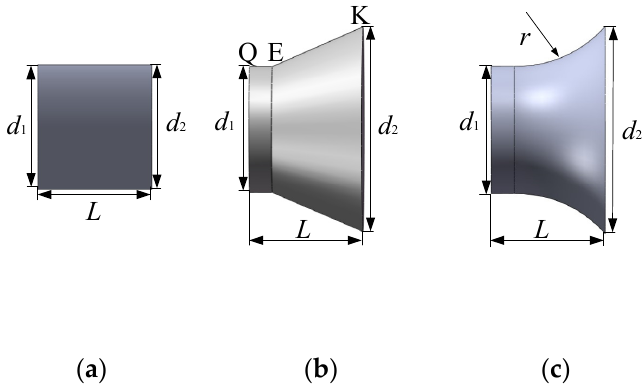
Figure 5. Structure of the seed disk hole: ( a ) cylindrical, ( b ) conical, ( c ) arc. Because of the different shapes of maize seeds can be divided into horse-tooth shapes, ellipsoid cone shapes and spheroid [34,35]. According to [36], it is known that the air- suction type seed metering device is the most difficult to suck horse-tooth shape maize seeds. From the formula of the diameter of the seed disk hole: d = 0.64 B~0.66 B [37], the average width B of horse-tooth shape seeds is 8.5 mm [35], so it is determined that the diameter d 1 of the inlet of the suction hole is determined to be 5.4~5.6 mm and the cross-sectional area of the seed disk hole entrance is 2.2 × 10 − 5 ~2.5 × 10 − 5 m 2 . The ratio of the velocity at a point in the flow field to the speed of sound at that point is called the local Mach number [38]; the calculation of the Mach number in the one-dimensional pipeline is shown in Equation (4):